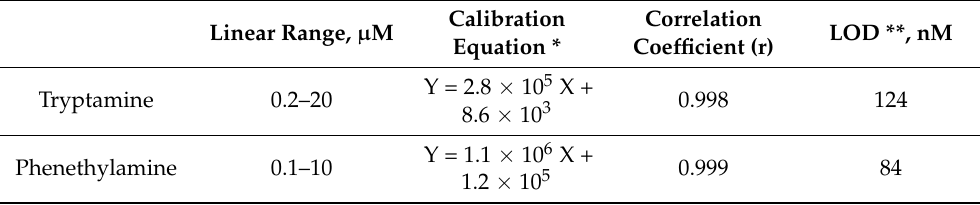
Table 1. Calibration curve and LOD of anthraquinone tagged amine. Linear Range, µ